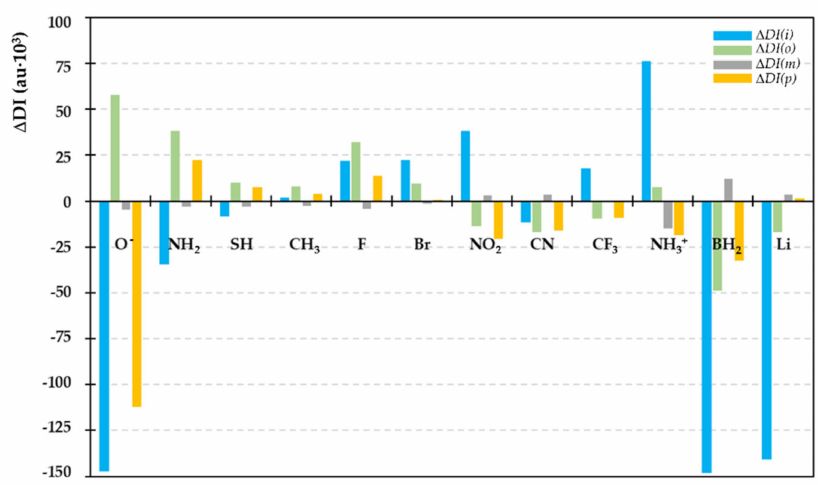
Figure 3. ∆ DI( a ) for the set of selected systems. See the text for a description. All data in au × 10 − 3 , referred to the vicinal DI in benzene, equal to 0.555 au: ∆ DI( a ) = DI( a ,X) − DI( a